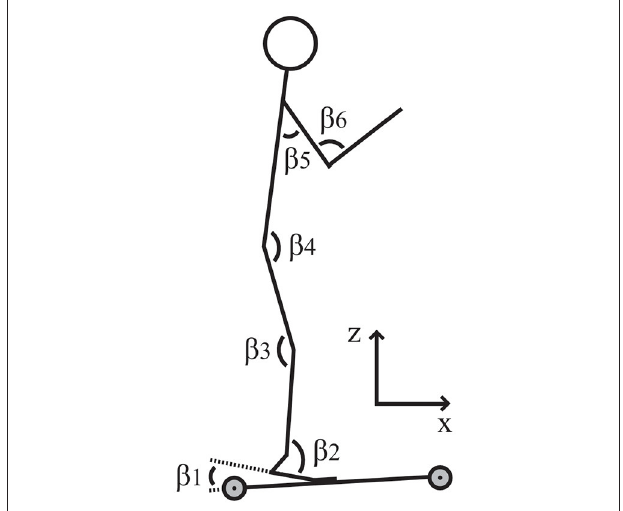
FIGURE 1 | Analyzed joint angles of the